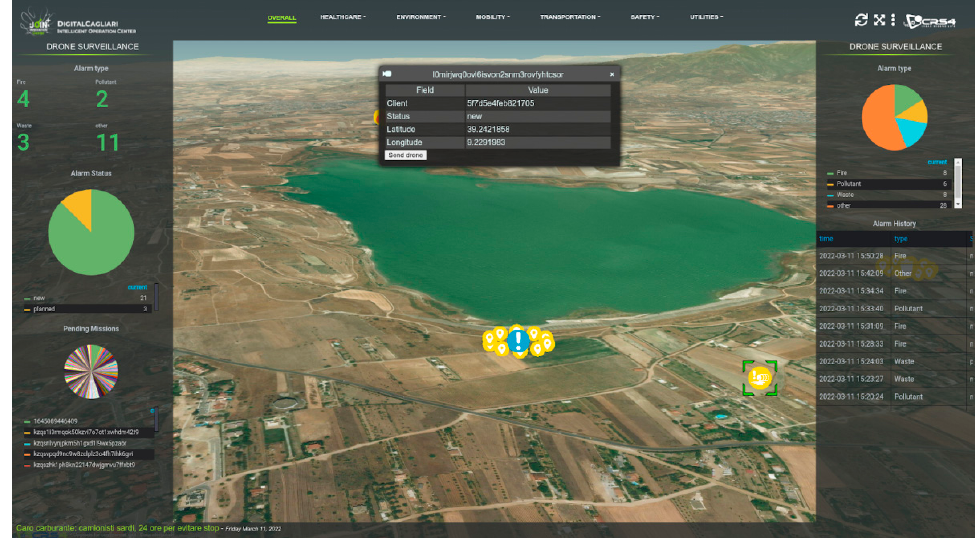
Figure 11. The on-site test shown on the smart city platform.